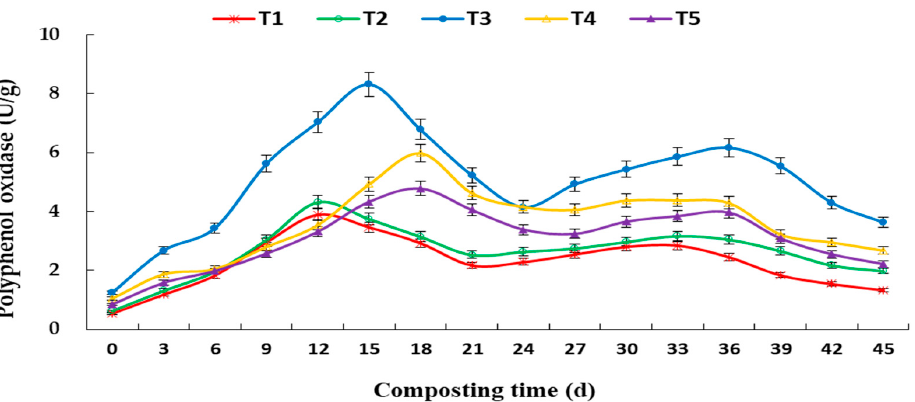
Figure 7. Changes of polyphenol oxidase activity during composting of corn straw and cow dung under different C/N ratios.